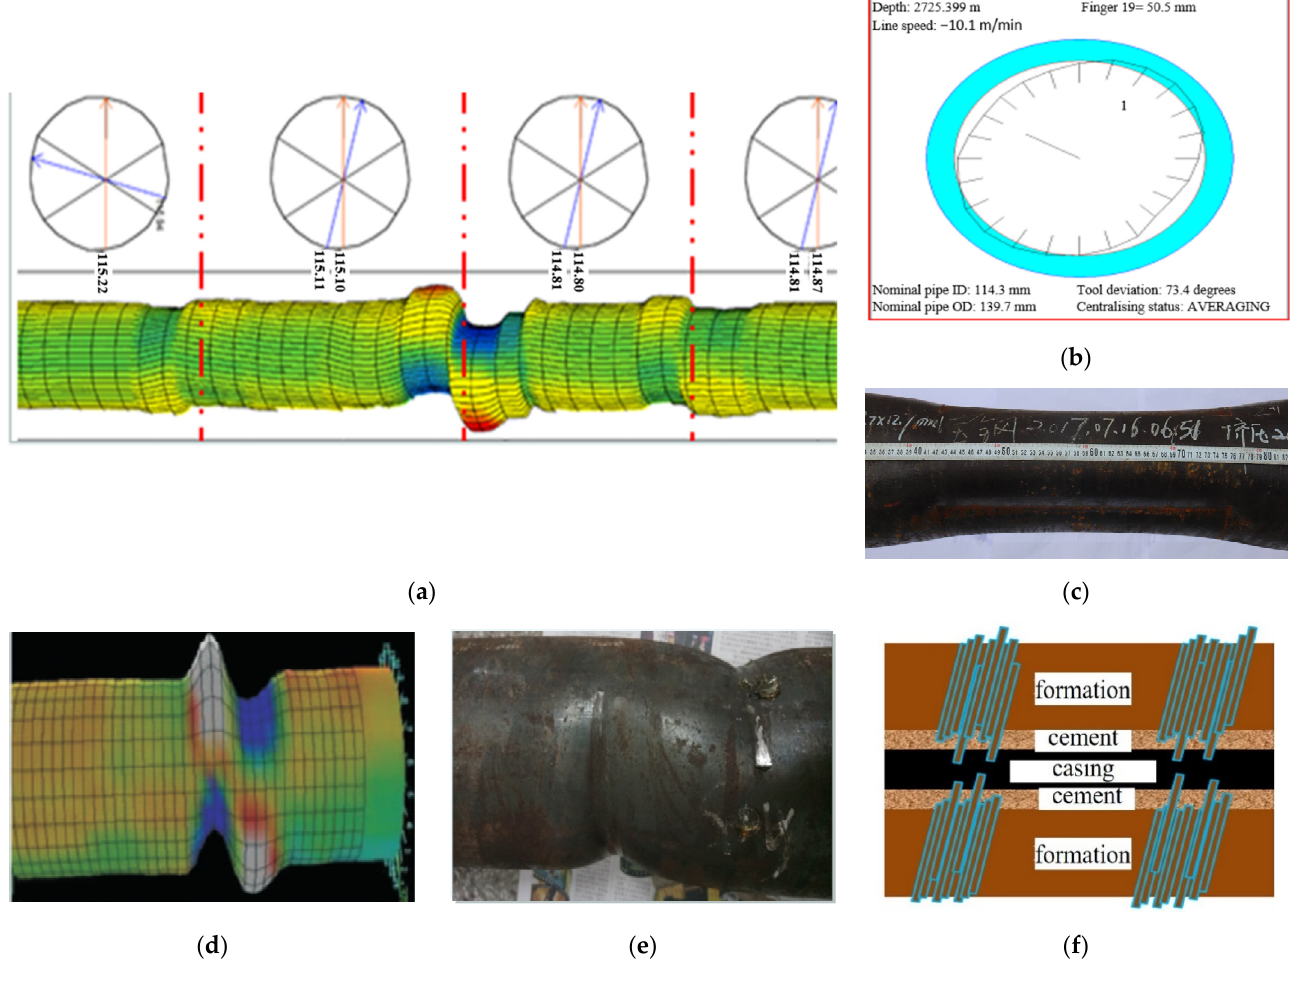
Figure 1. Typical deformation morphology of casing in a shale gas horizontal well: ( a ) logging morphology of a casing change well; ( b ) typical extrusion morphology; ( c ) extrusion test; ( d ) typical shear morphology; ( e ) shear test; ( f ) formation slip.